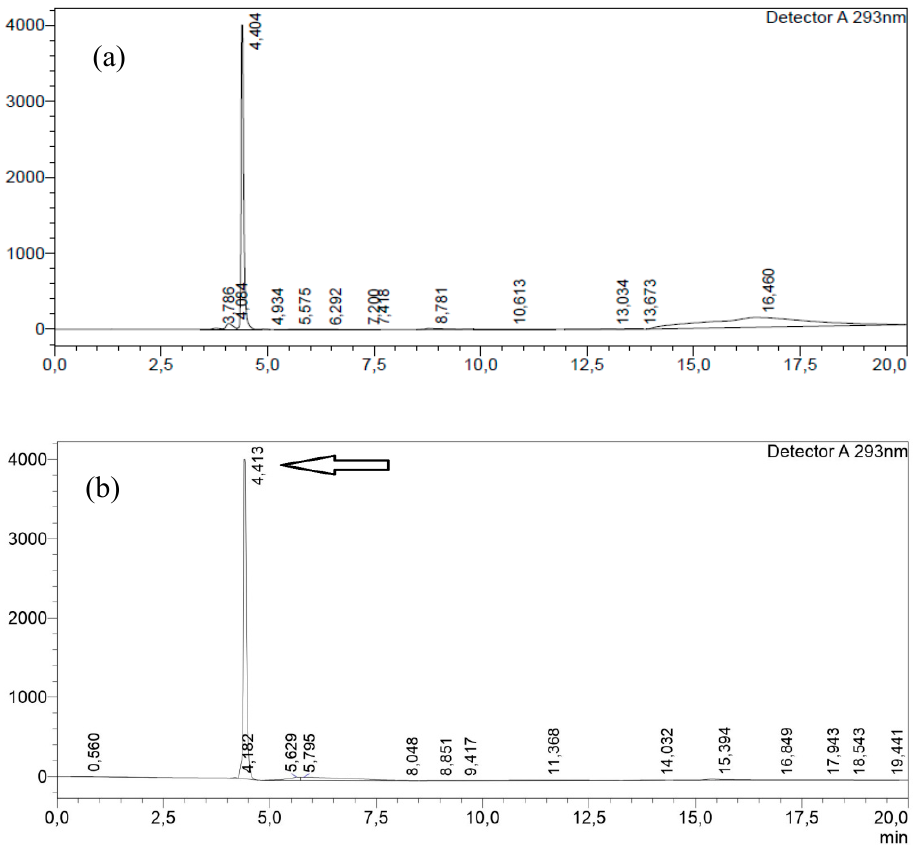
Figure 5. HPLC analysis for: ( a ) pure Lawsone; and ( b ) samples of dried leaves without ultrasound (Air) at 40 °C.